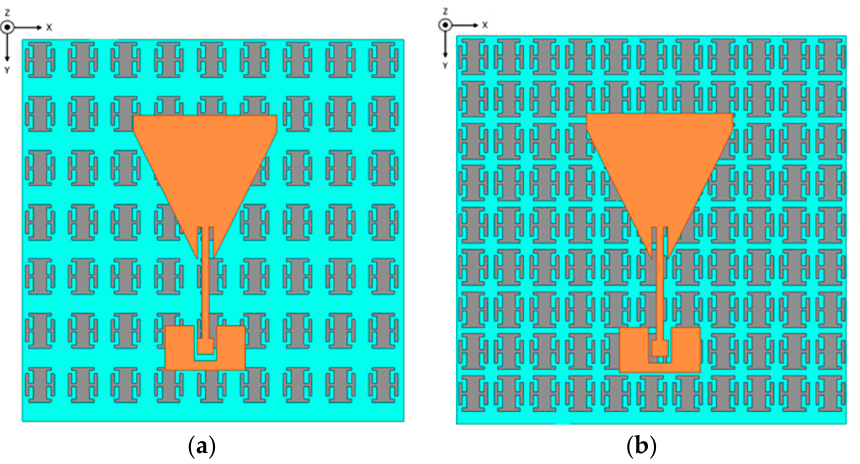
Figure 12. The periodic array size of the proposed AMC: ( a ) Type 1 regular array size is 7 × 9; ( b ) Type 2 regular array size is 9 × 11.